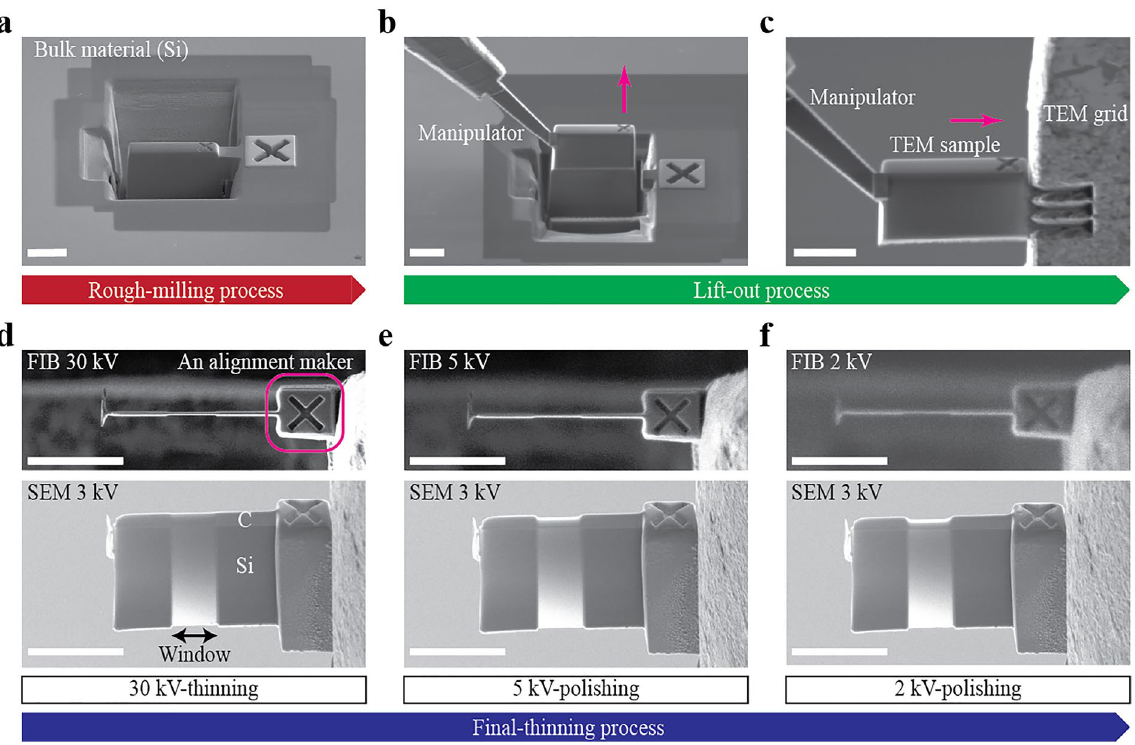
Figure 1. Robotic FIB operation to prepare a high-quality lamella. ( a ) Rough-milling process to prepare a chunk in a bulk. ( b ) The in-situ manipulator lifts out the chunk. ( c ) The chunk is transferred and fixed to a TEM grid at the position. After the FIB then cuts the tip of the manipulator to release the sample, the final- thinning process starts. ( d ) FIB and SEM (secondary electron) images after 30 kV thinning. Finally, the FIB thins and polishes a narrower “window” region of approximately 2.4 μm wide. ( e,f ) FIB and SEM images after FIB polishing at 5 kV and 2 kV, respectively. Preparing one STEM sample takes about 1 h (see Table 1). The scale bars shown in both FIB and SEM images are 5 μm